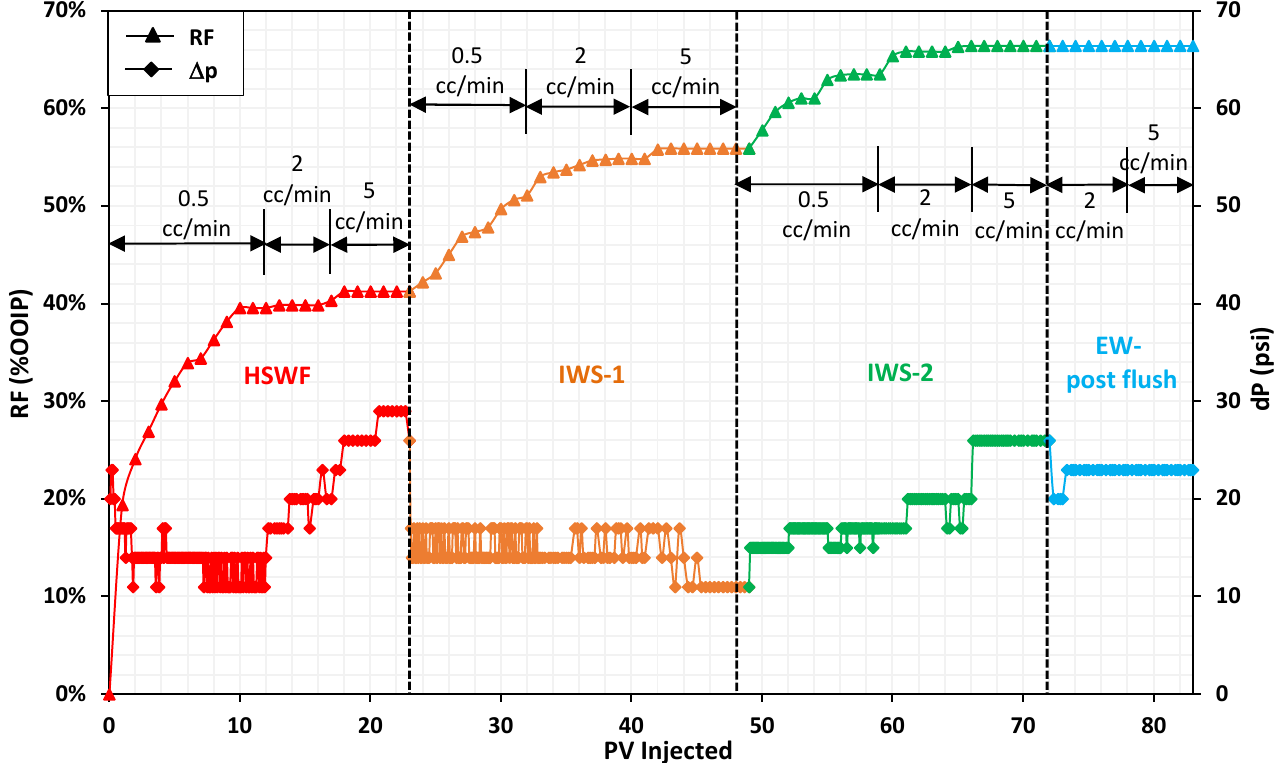
Figure 6. Pressure drop and oil recovery profile for CF-2 with a sharper negative salinity gradient.